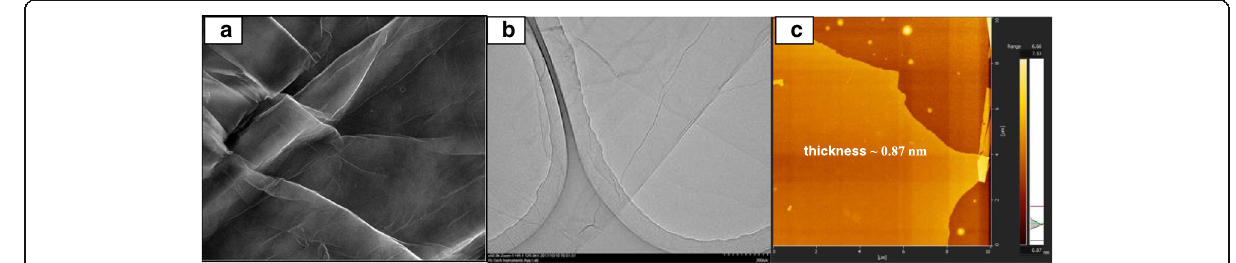
Fig. 5 FESEM, TEM, and AFM image of exfoliated graphene